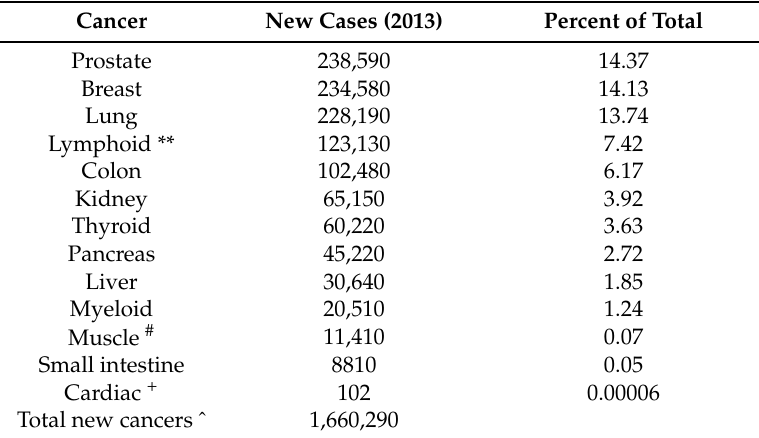
Table 2. Incidence of selected cancers in the United States in 2013